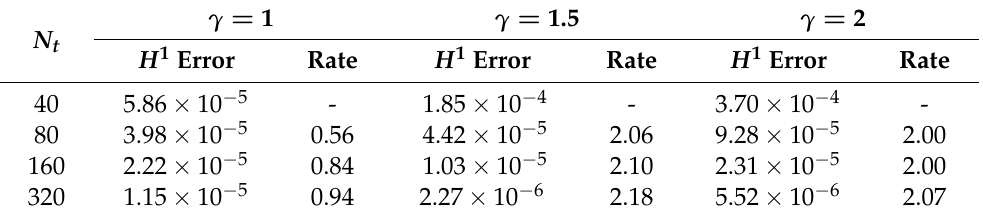
Table 3. The H 1 -norm errors in time for the non-smooth case in Example 1 with h = 1/64 and α = 1.5.